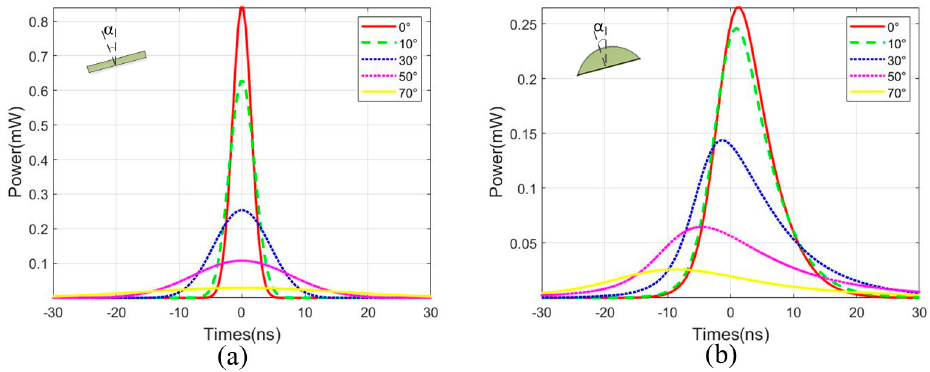
Figure 15. The echoes of different targets rotating at different angles. ( a ) A plane; ( b ) A